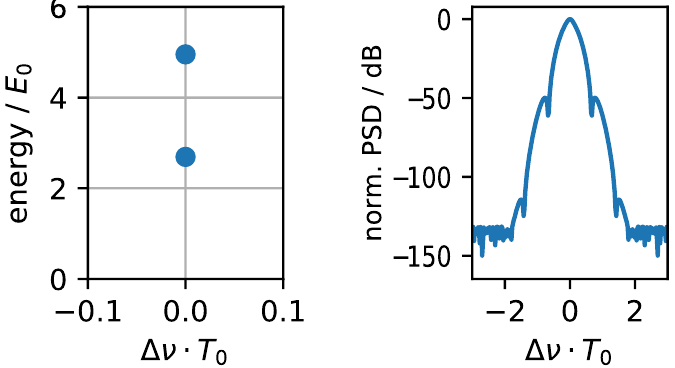
Figure 8. Nonlinear spectrum calculated for a Gaussian pulse shape (Equation (18)) with A 0 = 3 and P 0 , T 0 fulfilling Equation (4). (Left) The discrete spectrum, consisting of two solitons of the same center frequency. The reference energy here is chosen as E 0 = 2 P 0 T 0 . (Right) The power spectral density (PSD) of the linear radiation